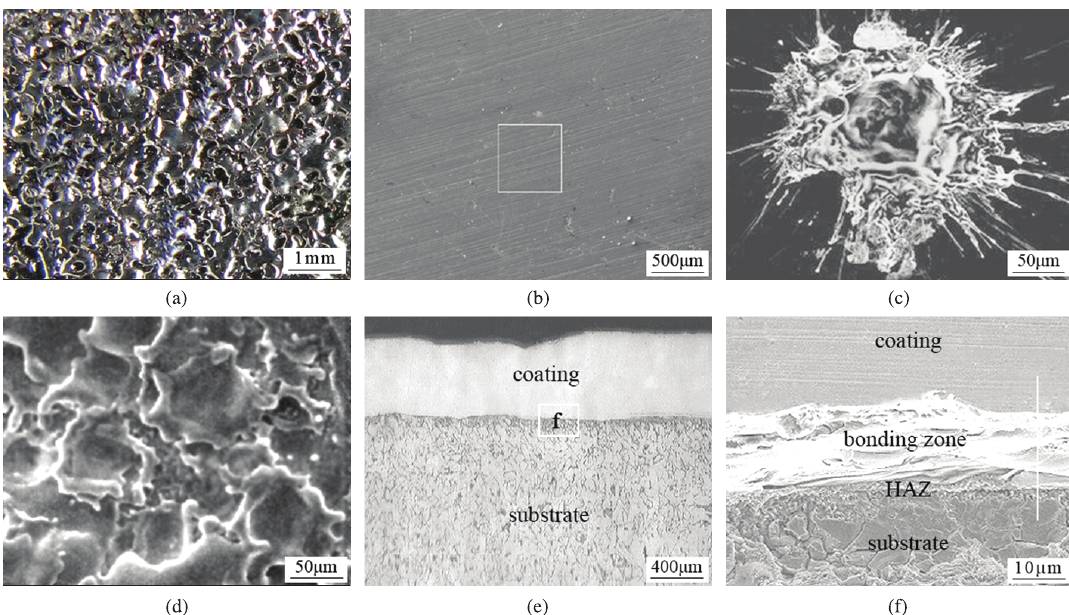
Figure 1. Surface morphology, cross section morphology of the coating. (a) Surface macromorphology; (b) Surface micromorphology; (c) Single pulse discharge crater; (d) Discharge craters overlapping; (e) Cross section morphology in low magnification; (f) Cross section morphology in high